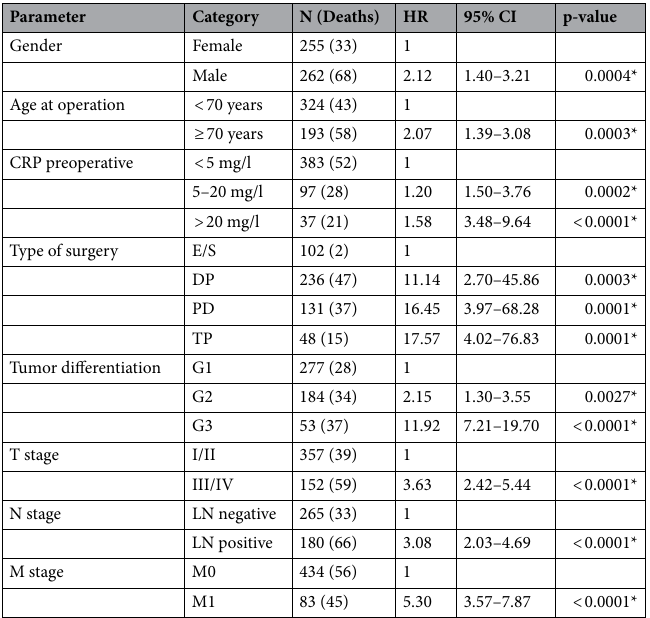
Table 3. Univariable Cox regression analysis of parameters associated with overall survival in n = 517 pancreatic neuroendocrine neoplasms after surgical treatment. HR hazard ratio, CI confidence interval, CRP C-reactive protein, PD pancreatoduodenectomy, DP distal pancreatectomy, TP total pancreatectomy, E/S enucleation/segmental resection, LN lymph node. *Statistically